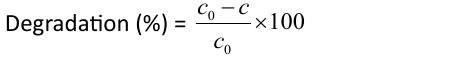
Fig. 9 (a) The photodegradation of MB vs. time and (b) the degradation rate constant with a first-order kinetic function for Cd -